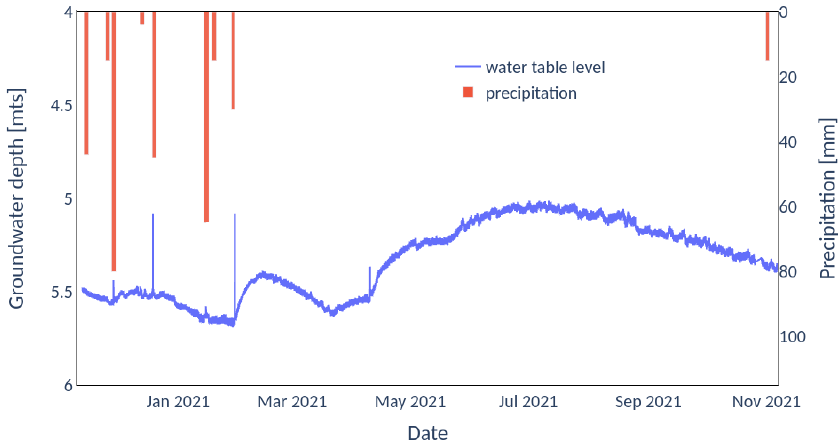
Figure 10. Water table level variation at the study site (see Figure 7, location